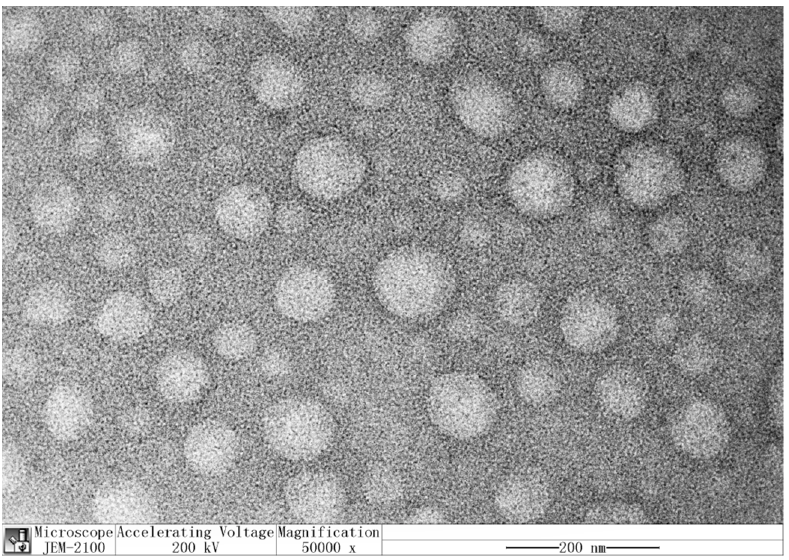
Figure 2. TEM (transmission electron microscopy) images of PPNPS. The concentration of PPNPS was 1 mg/mL.